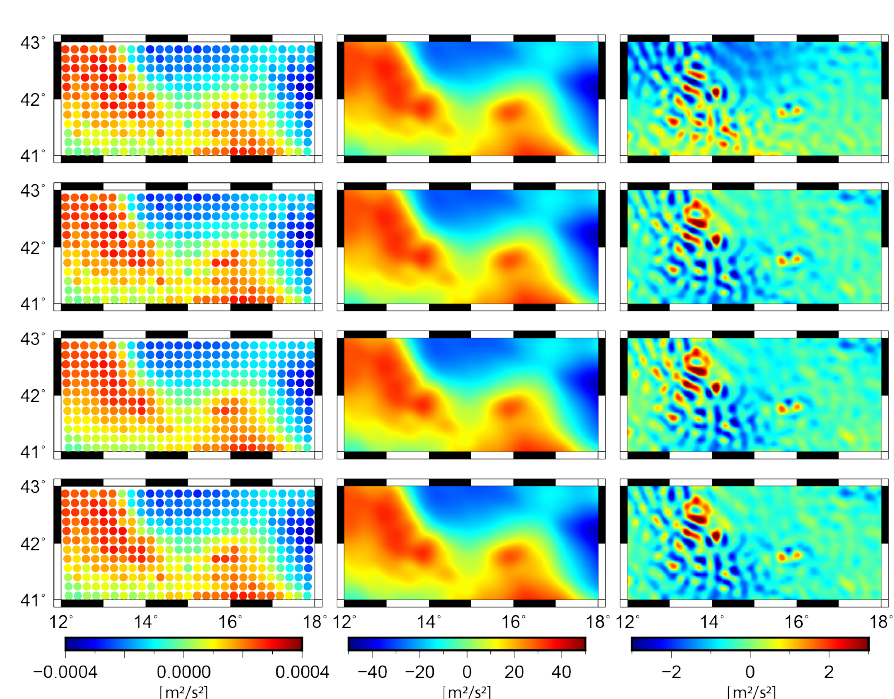
Figure 8. The estimated coefficients d k ( left column ), the recovered disturbing potential T c ( mid column ), and the differences w.r.t the validation data ( right column ) for study case F. The results are obtained using: the L-curve method ( first row ), VCE ( second row ), VCE-Lc ( third row ) and Lc-VCE ( fourth row